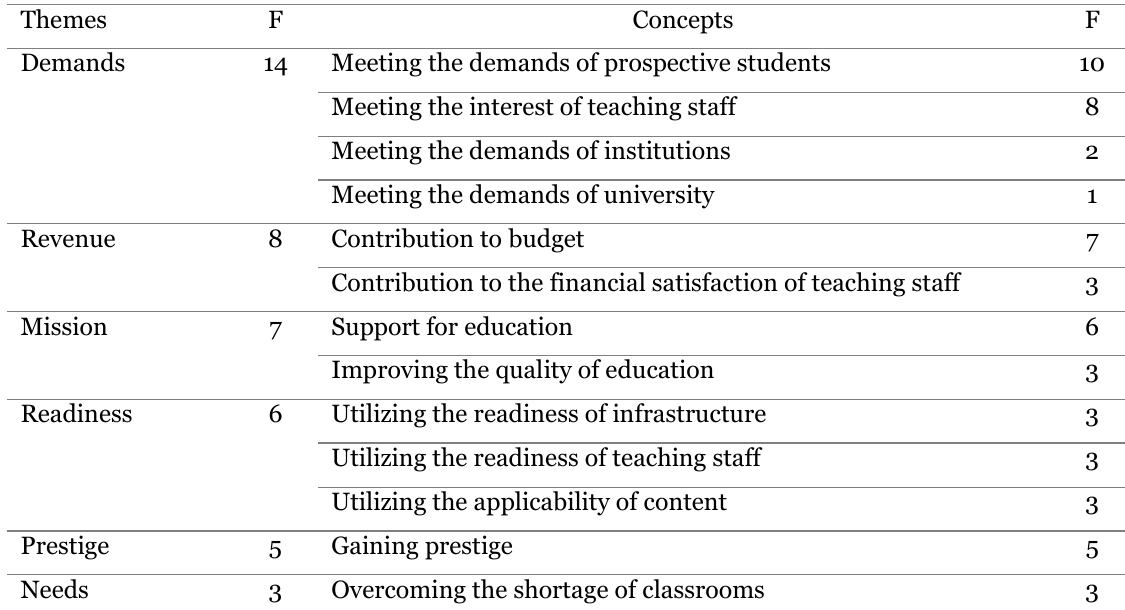
Administrators' Conceptions and Frequencies about the Motives of Offering Online Master's Degree Programs